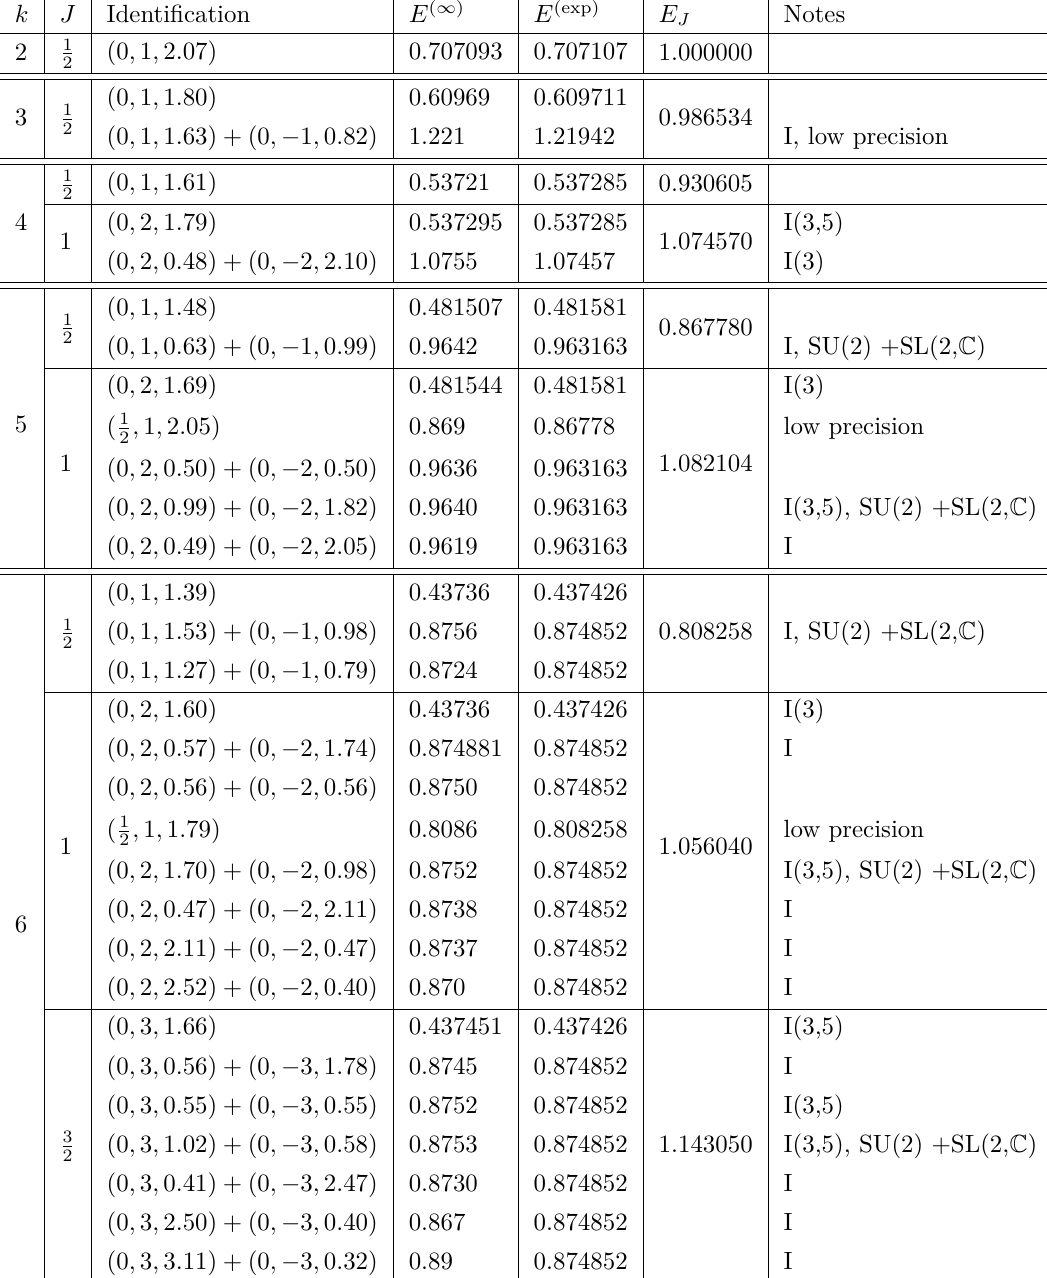
Table 14 . List of SL(2, C ) Cardy solutions in models with k ≤ 8 , part 1. The table has the same format as table 10. Identification of solutions includes the parameter J , the angle θ in multiples of π and the parameter ρ . In case of solutions with higher degeneracy, we show only one example. These solutions are pseudo-real, so the note R means that the given solution changes from generically complex to pseudo-real. The note I denotes instability at odd levels. If there are numbers in brackets, the instability appears only at these levels, otherwise all odd levels are unstable. The notes also mark solutions that probably describe combinations of SU(2) and SL(2, C )